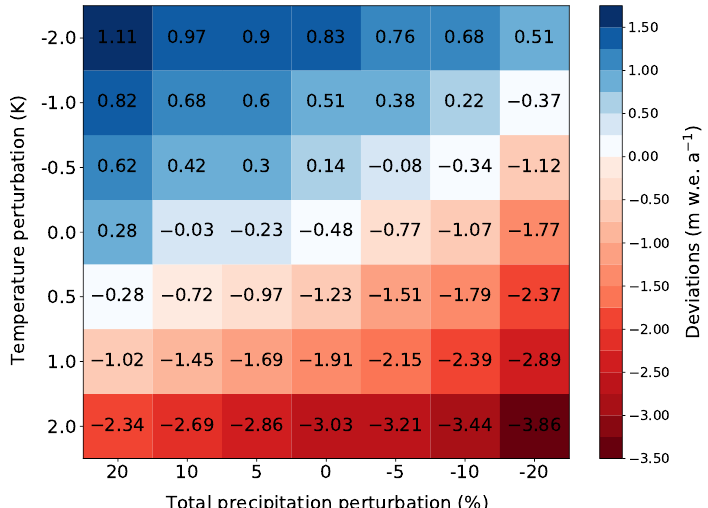
Figure 8. Mean (1982–2019) annual glacier-wide climatic mass balance (mw.e.a −1 ) deviations from reference run ( B clim , a = −0.48mw.e.a −1 ) for different overall temperature and total precipitation perturbations. The values within each pixel displays the actual mean B clim , a of the corresponding perturbation simulation. Please note that the color bar of the deviations is not centered around zero, reflecting the nonlinear response to same positive and negative